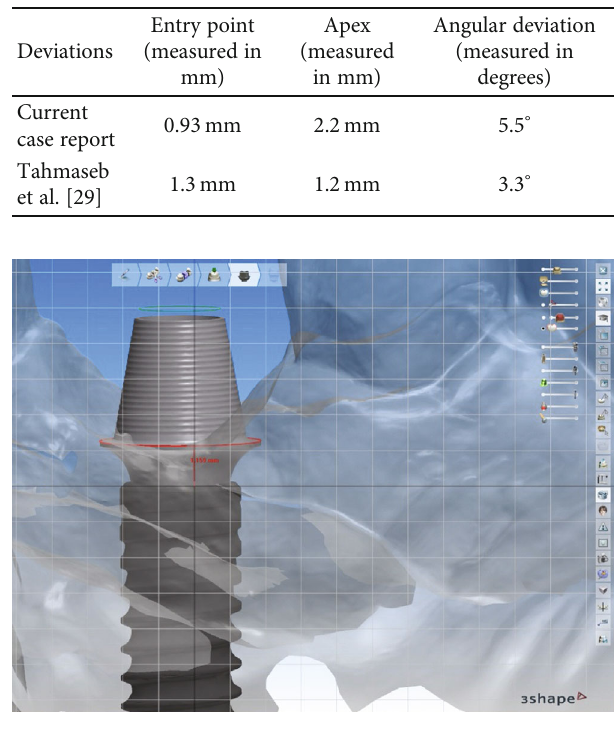
Figure 11: Evaluation of the abutment selected prior to the surgical procedure, demonstrating the accuracy of the technique.